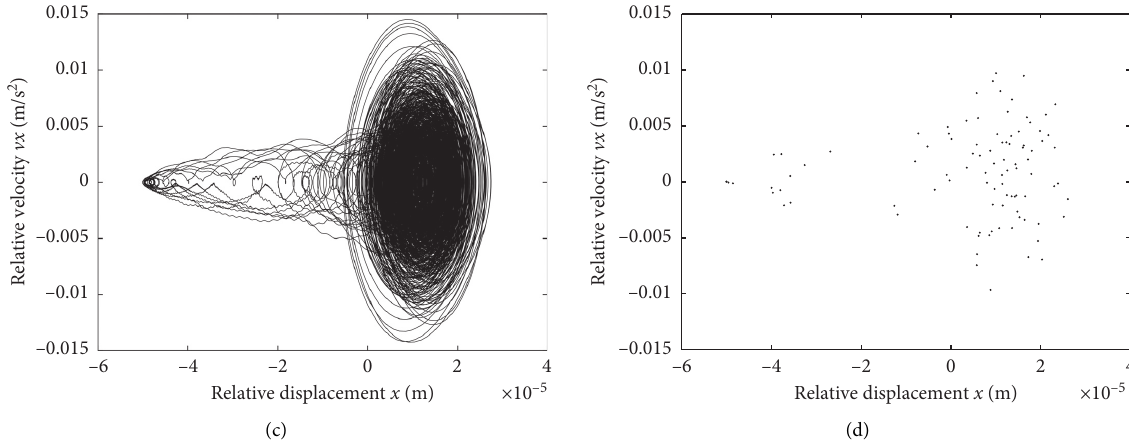
Figure 28: Phase trajectories and Poincare maps of X -direction clearances with different clearance values at clearance C. (a) Phase trace � − 2 π ( rad/s ) , ω � 2 π ( rad/s ) . (b) Poincare map at clearance C when the driving diagram at clearance C when the driving velocities are ω 2 7 � − 2 π ( rad/s ) , ω � 2 π ( rad/s ) . (c) Phase trace diagram at clearance C when the driving velocities are velocities are ω 2 7